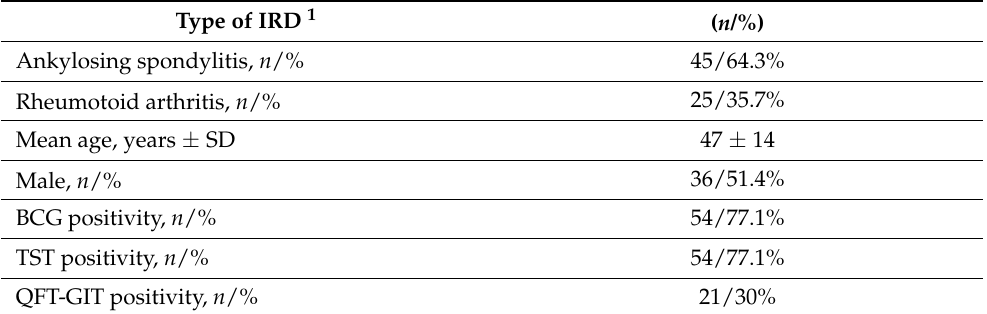
Table 1. Characteristics of the patients ( n = 70).